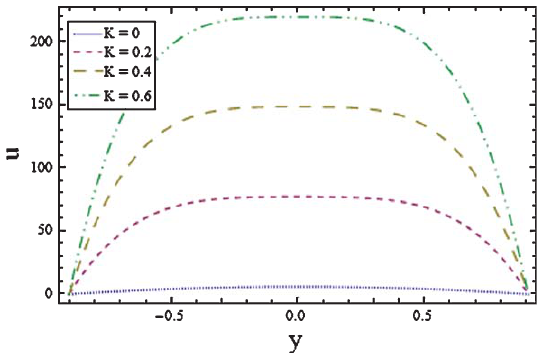
Fig. 3. Plot of longitudinal velocity u for various values of the Eyring-Powell fluid parameter K with (cid:15) = 0 . 2, x = 0 . 02, t = 0 . 1 , M = 0 . 5 , E = 0 . 3 , E = 0 . 2 , and E = 0 . 1. 1 2 3